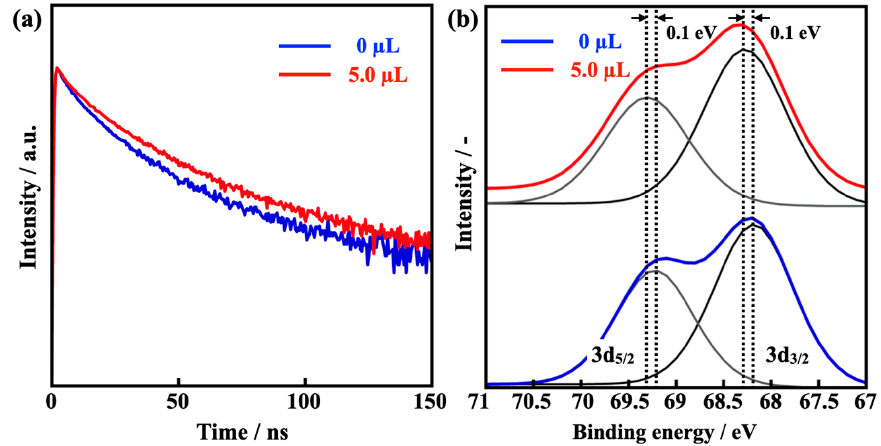
Figure 6. ( a ) PL decay curved and ( b ) XPS spectra of the MAPbBr 3 PeQDs without water (0 µL) and water-assisted (5 µL). Table 2. PL decay time constant, a short-lifetime, and a long lifetime of MAPbBr 3 PeQDs prepared without water (0 µL) and with water (2.5–7.5 µL).